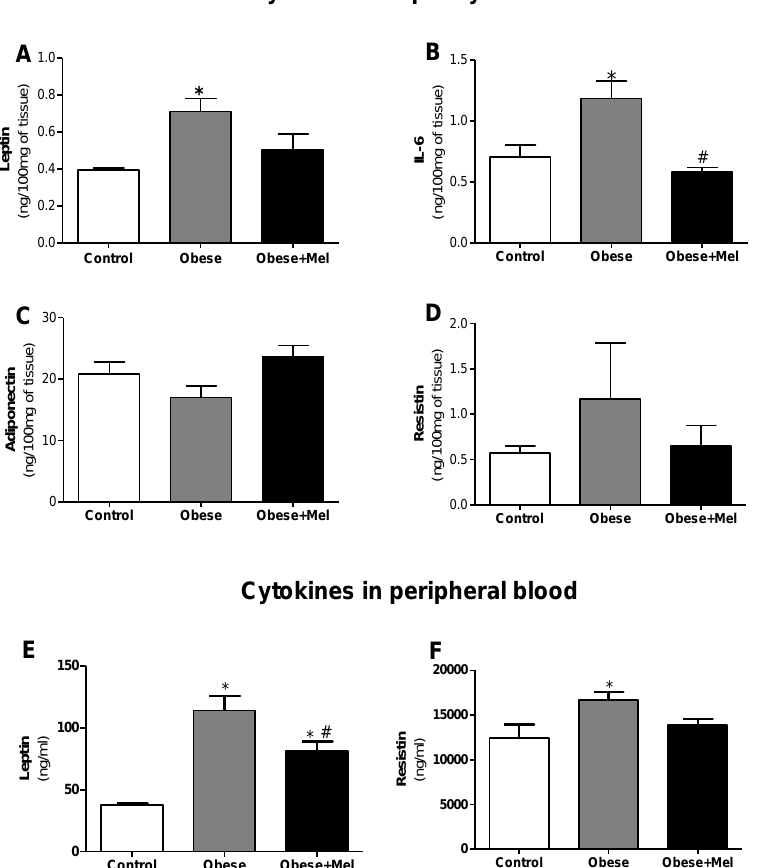
Figure 4. E ff ects of the high-fat diet (HFD) and melatonin supplementation (Mel, 1 mg / kg b.w., diluted in drinking water, daily, for 10 weeks) on ELISA analysis of cytokine levels in lysates from epididymal (EPI) WAT and peripheral blood from mice. ( A ) Leptin expression on the EPI depot, ( B ) Il-6 expression on the EPI depot, ( C ) adiponectin expression on the EPI depot, ( D ) resistin expression on the EPI depot, ( E ) leptin expression on peripheral blood, and ( F ) resistin expression on peripheral blood. Results were analyzed by a one-way ANOVA and a Tukey post-test. Values are mean ± SEM (Control n = 10; Obese n = 9; Obese + Mel n = 11). * p < 0.05 vs. Control; # p < 0.05 vs.